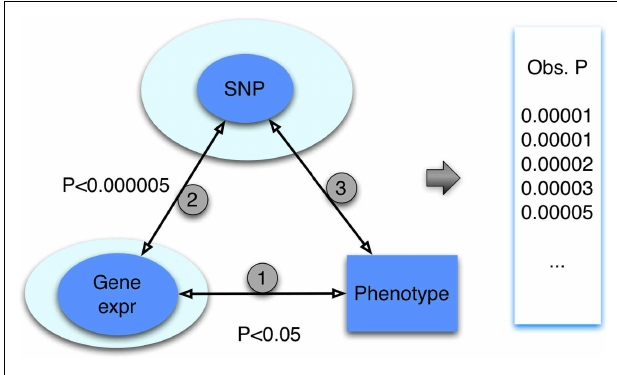
FIGURE 1 |The use of omics data to perform SNP filtering. A series of functional filters is applied to the original SNP set to perform data dimensional reduction.The reduced multiple testing burden may improve power to detect genotype associations with phenotype.